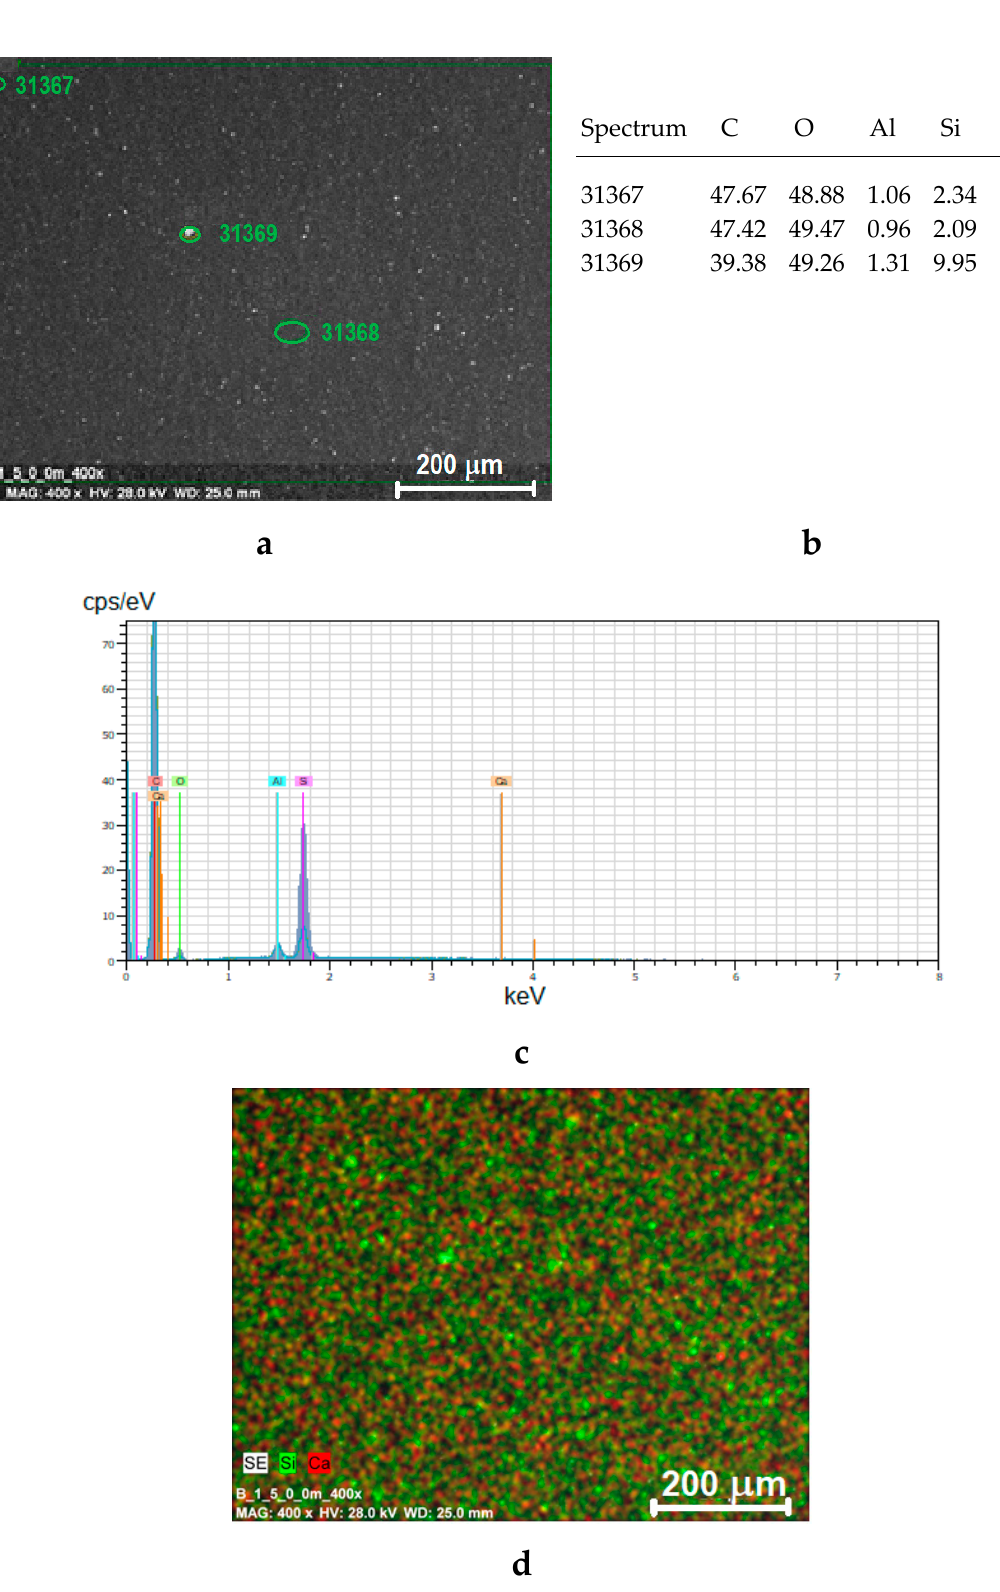
Figure 2. SEM images of Sillikolloid P87 ( a ), MDPE + 5% Sillikolloid P87 non-oriented (NO) ( b ), MDPE + 5% Sillikolloid P87 oriented (O) ( c ), MDPE + 10% Sillikolloid P87 oriented (O) ( d ); c–d, cross-sections.